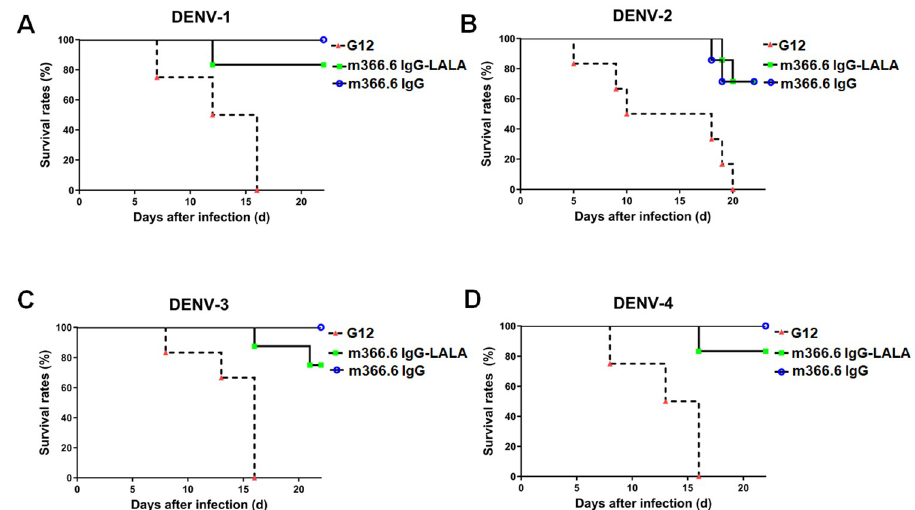
Fig 5. In vivo therapeutic efficacy of m366.6 against DENV1-4 infection. Groups of one day old suckling mice were administrated with 100 μ g of mAbs 4 hours after challenge with 200 PFU of DENV-1 (A), DENV-2 (B), DENV-3 (C), and DENV-4 (D), respectively. Unrelated antibody G12 was used in the negative controls. The number of animals for each group ranged from 6 to 9. Kaplan-Meier survival curves were analyzed by the log-rank test and compared to curves of the